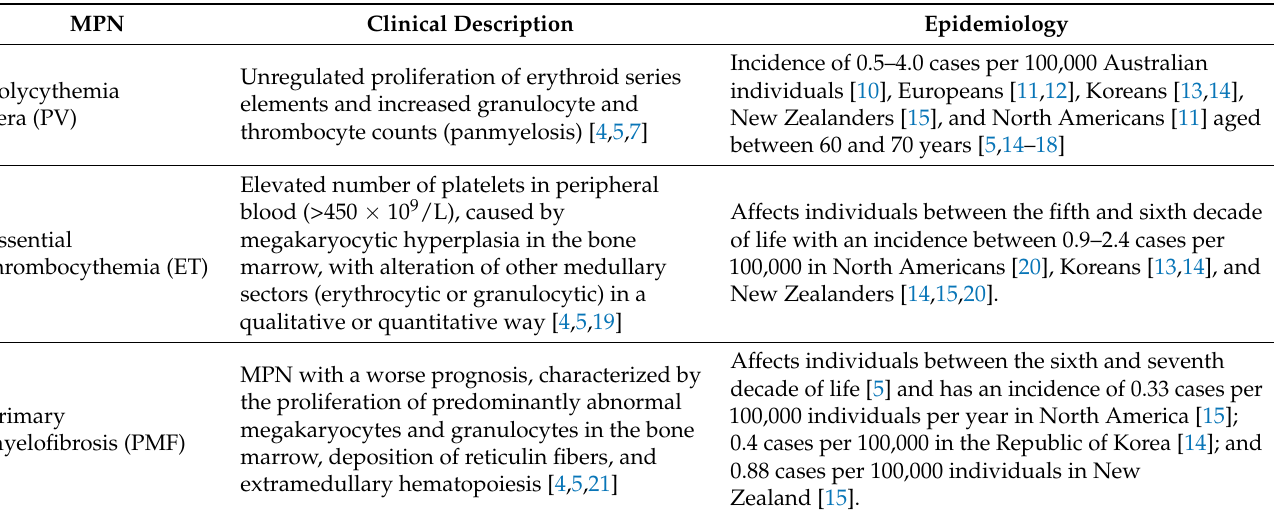
Table 1. Features of BCR-ABL1 -negative myeloproliferative neoplasms. MPNs: myeloprolifera- tive